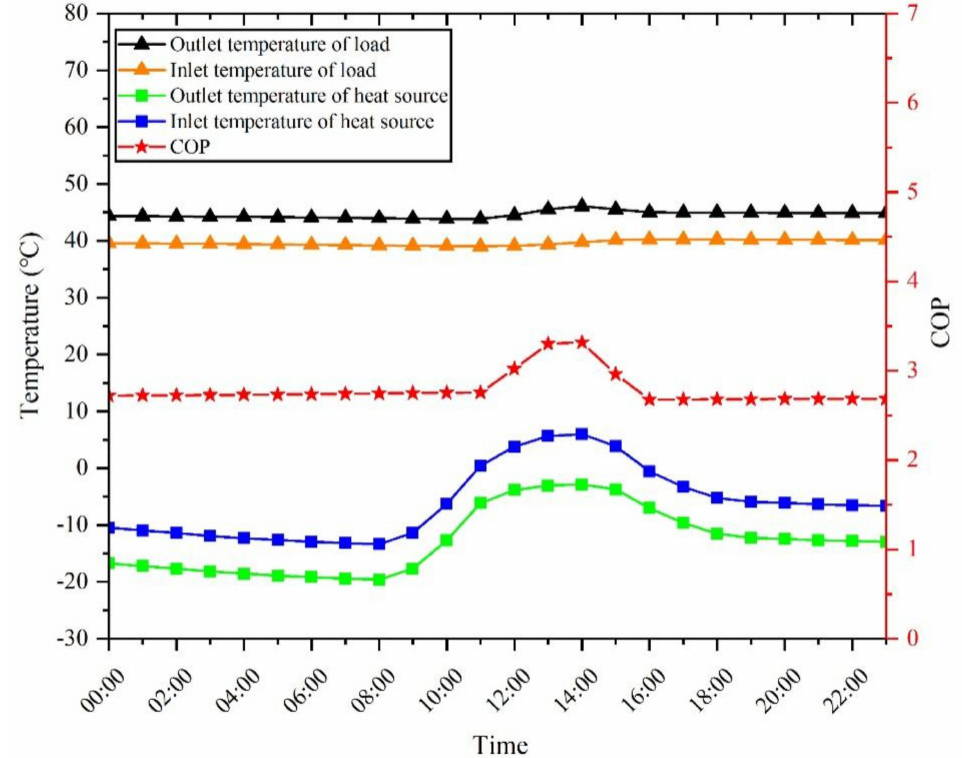
Figure 6. Operation performance of AHP on 15 January.